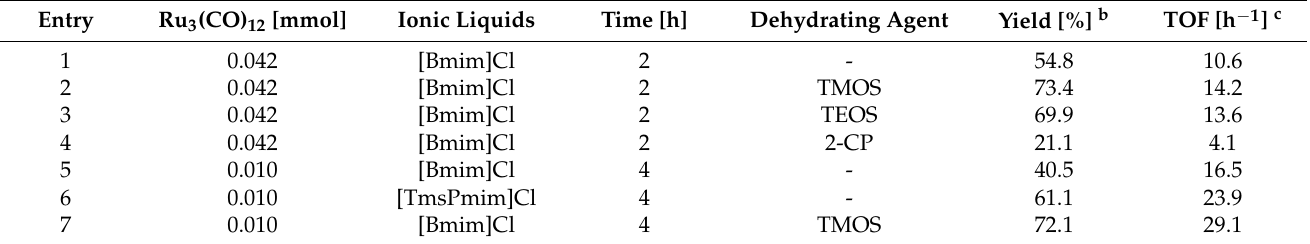
Table 1. Effects of dehydrating agents on hydroesterification reaction a